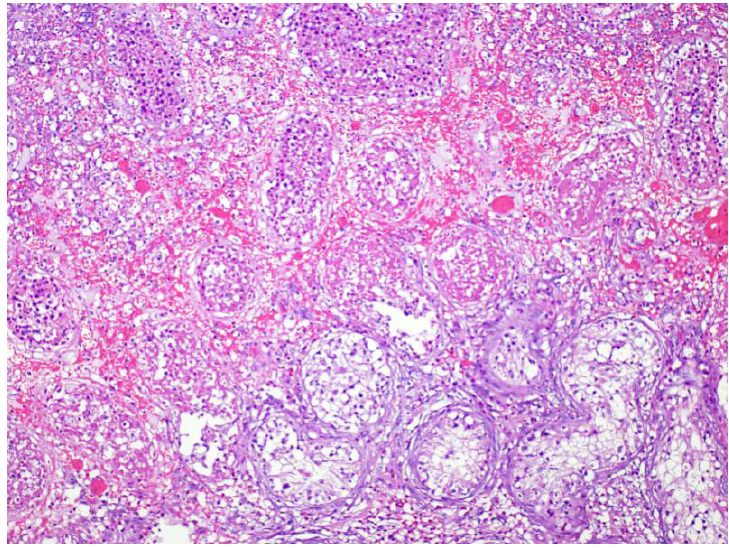
FIGURE 2. Histopathological image with hematoxylin and eosin stain of right testis (original magnification ×100). Focal testicular infarcts and recent bleeding are seen.